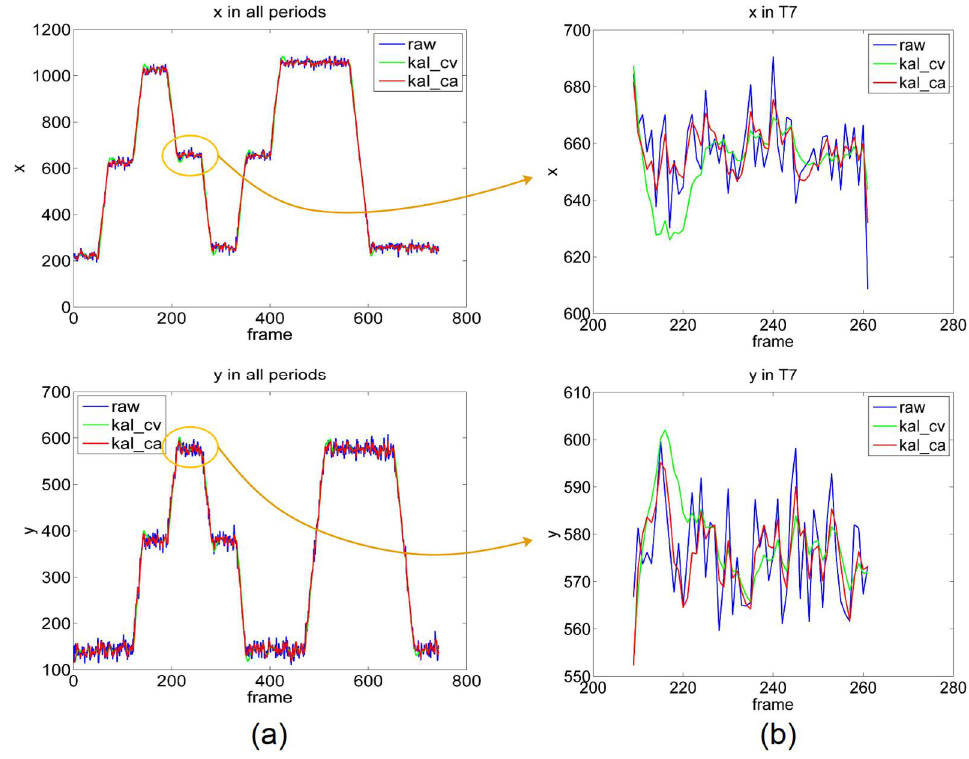
Figure 12. x- and y-values in the saccade task. ( a ) Overall result of all periods. ( b ) Local result of period